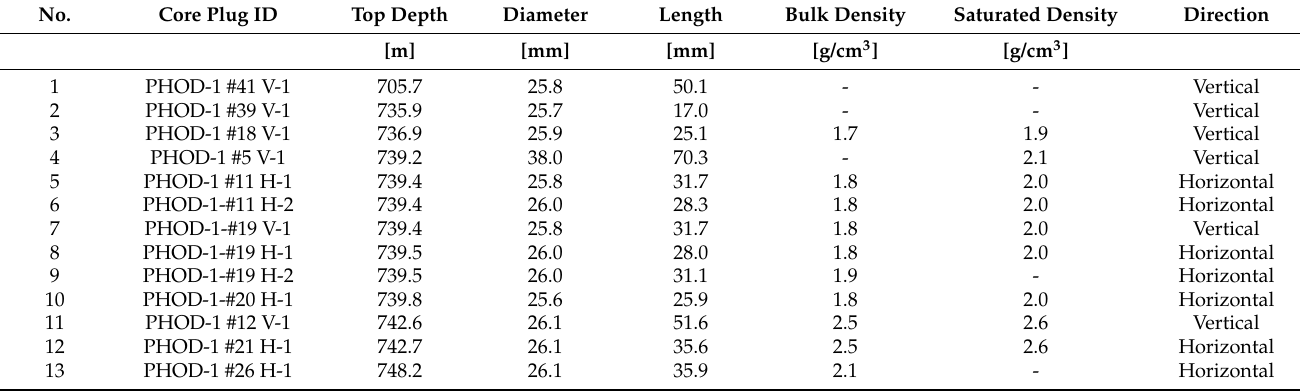
Table A1. Properties of recovered core plugs from well PHOD-1 and densities of directionally prepared core